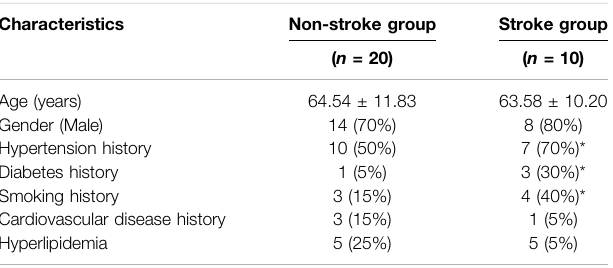
TABLE 1 | Demographics and the distribution of the comorbid conditions in the study sample. Characteristics